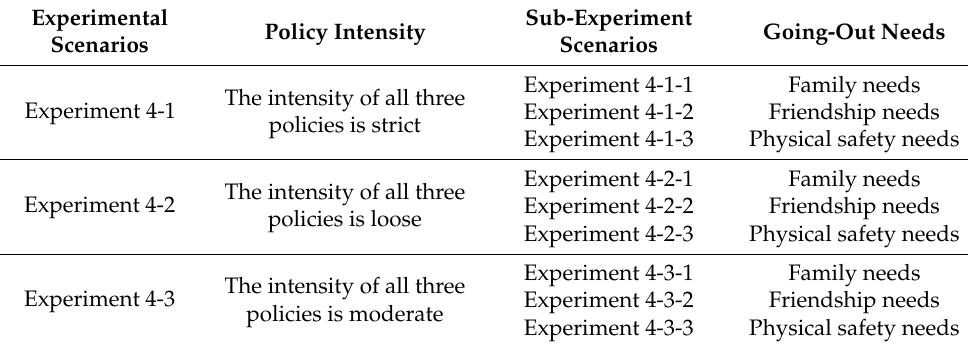
Table 4. Basic experiments based on different kinds of going-out needs. Experimental Policy Scenarios